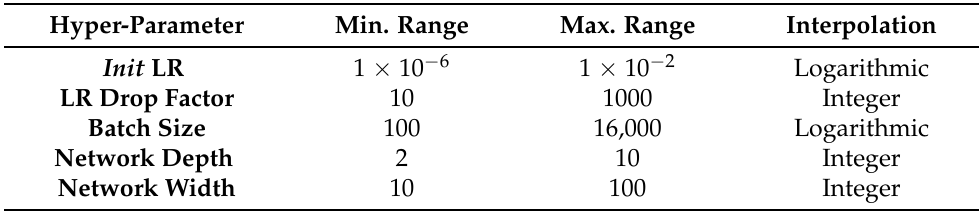
Table 1. Optimization matrix with interpolation strategies and range of investigation for each